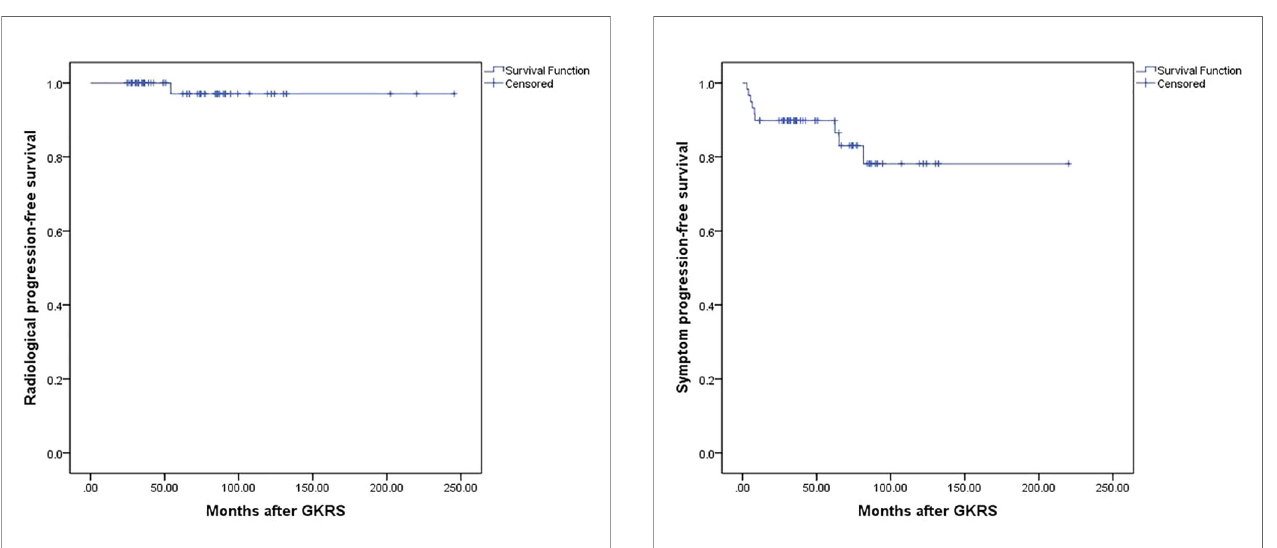
FIGURE 3 | Kaplan-Meier curve of Symptom progression-free survival for the entire series.